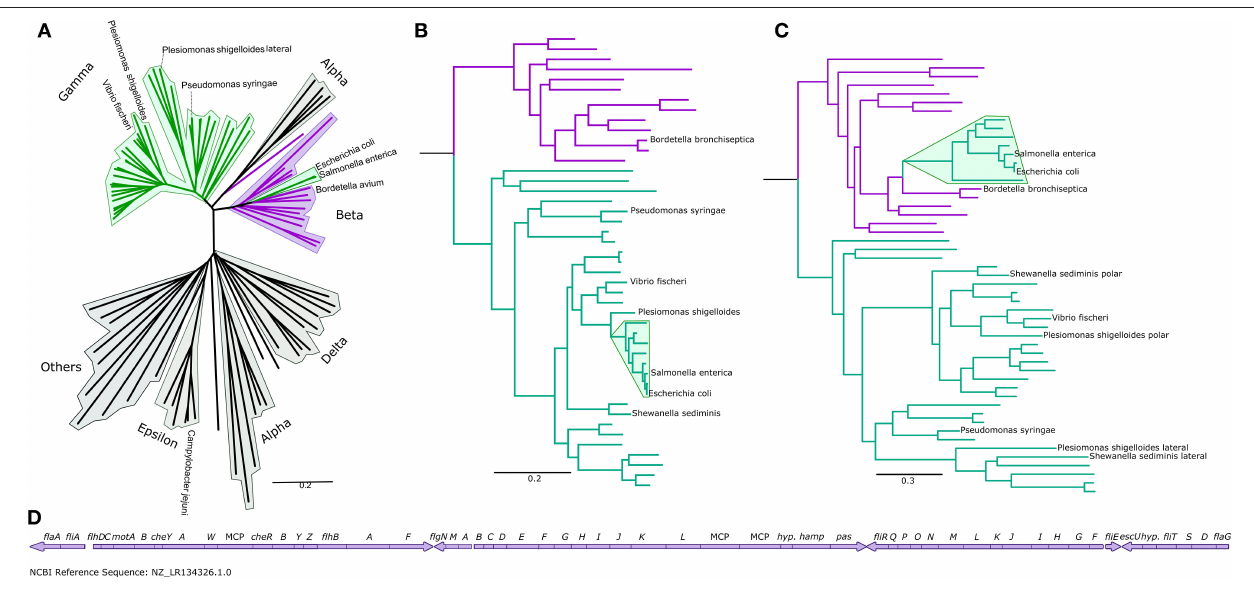
FIGURE 1 | The Enterobacteriaceae have β -like motors. (A) An unrooted global flagellar phylogeny. γ -proteobacteria are highlighted in green: the enteric Enterobacteriaceae γ -proteobacteria ( Salmonella enterica and Escherichia coli ) are not clustered with the other γ -proteobacteria, but are clustered within the β -proteobacteria (purple). Fully annotated version of this tree is presented in Supplementary Figure S1. (B) An organismal phylogeny focused on γ - (green) and β -proteobacteria (purple), rooted with an ε -proteobacterium, Campylobacter jejuni . The Enterobacteriaceae are highlighted in green. Fully annotated version of this tree is presented in Supplementary Figure S4. (C) The flagellar phylogeny of the γ - (green) and β -proteobacteria (purple). Note the shift in position of the Enterobacteriaceae (highlighted in green) from the γ -proteobacterial clade to within the β -proteobacterial clade. Rooted with Campylobacter jejuni . Fully annotated version of this tree is presented in Supplementary Figure S5. (D) The Bordetella bronchiseptica flagellar gene cluster is arranged in one continuous genetic locus.